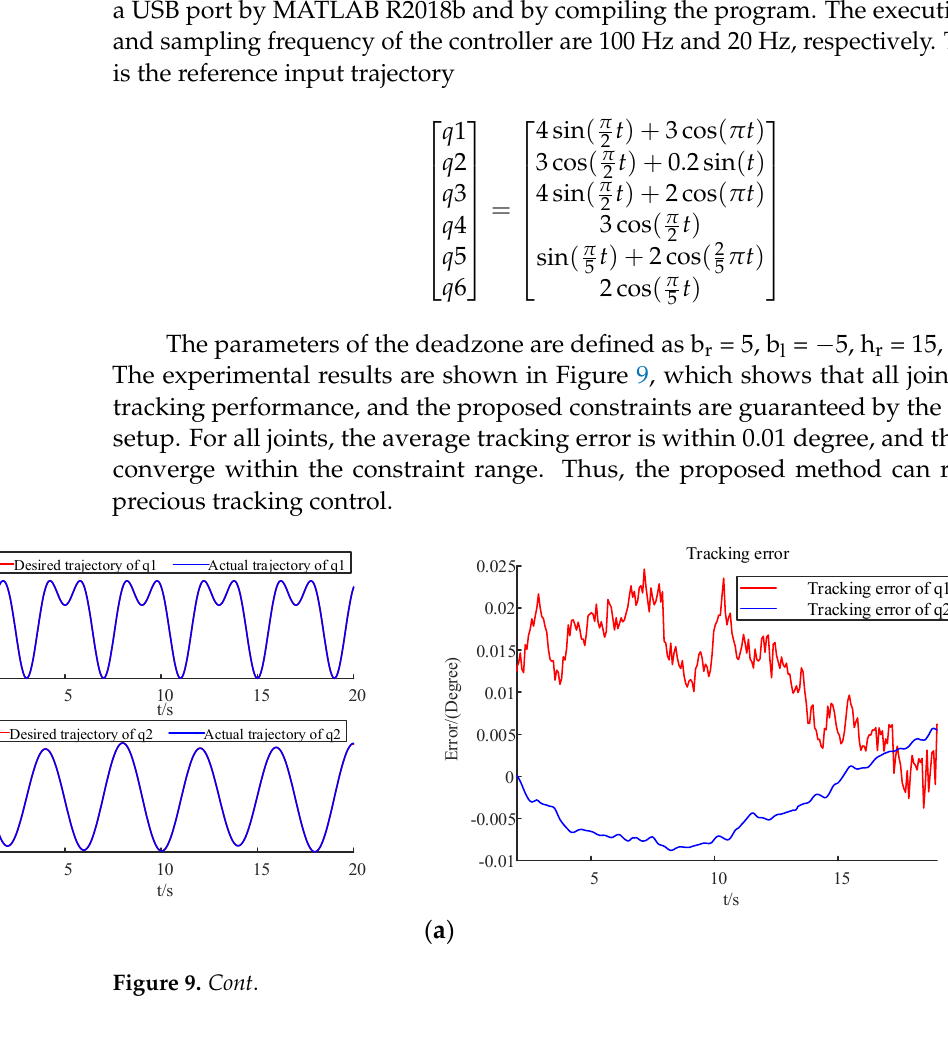
Figure 8. Tracking error under different methods. Table 3. Performance comparison. Methods Figure 1. The type of manipulator is a collaborative ultralight robot, JAKA zu7s. The